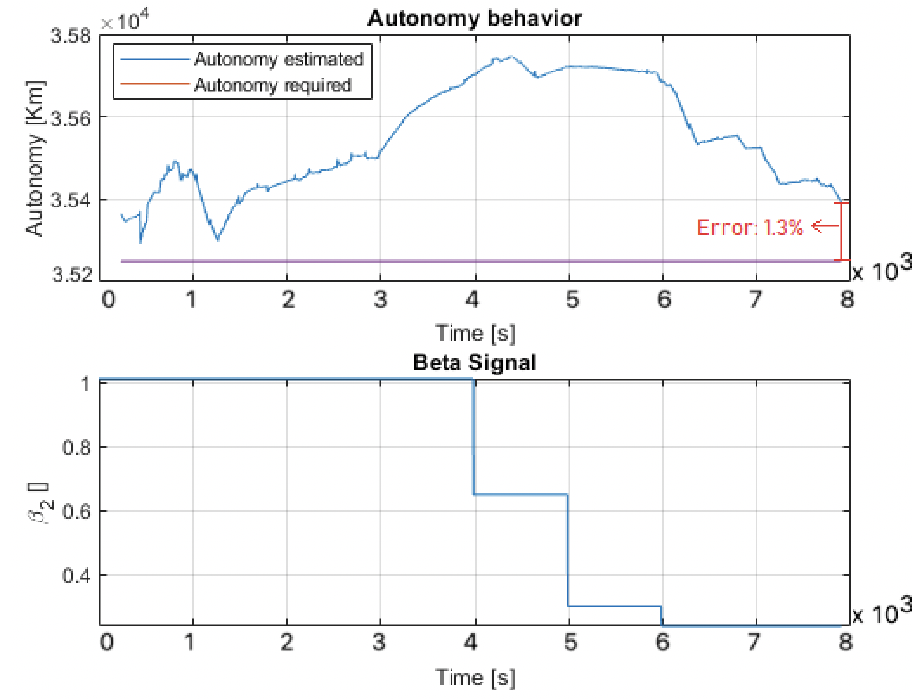
Figure 28. Correct urban/rural estimation.